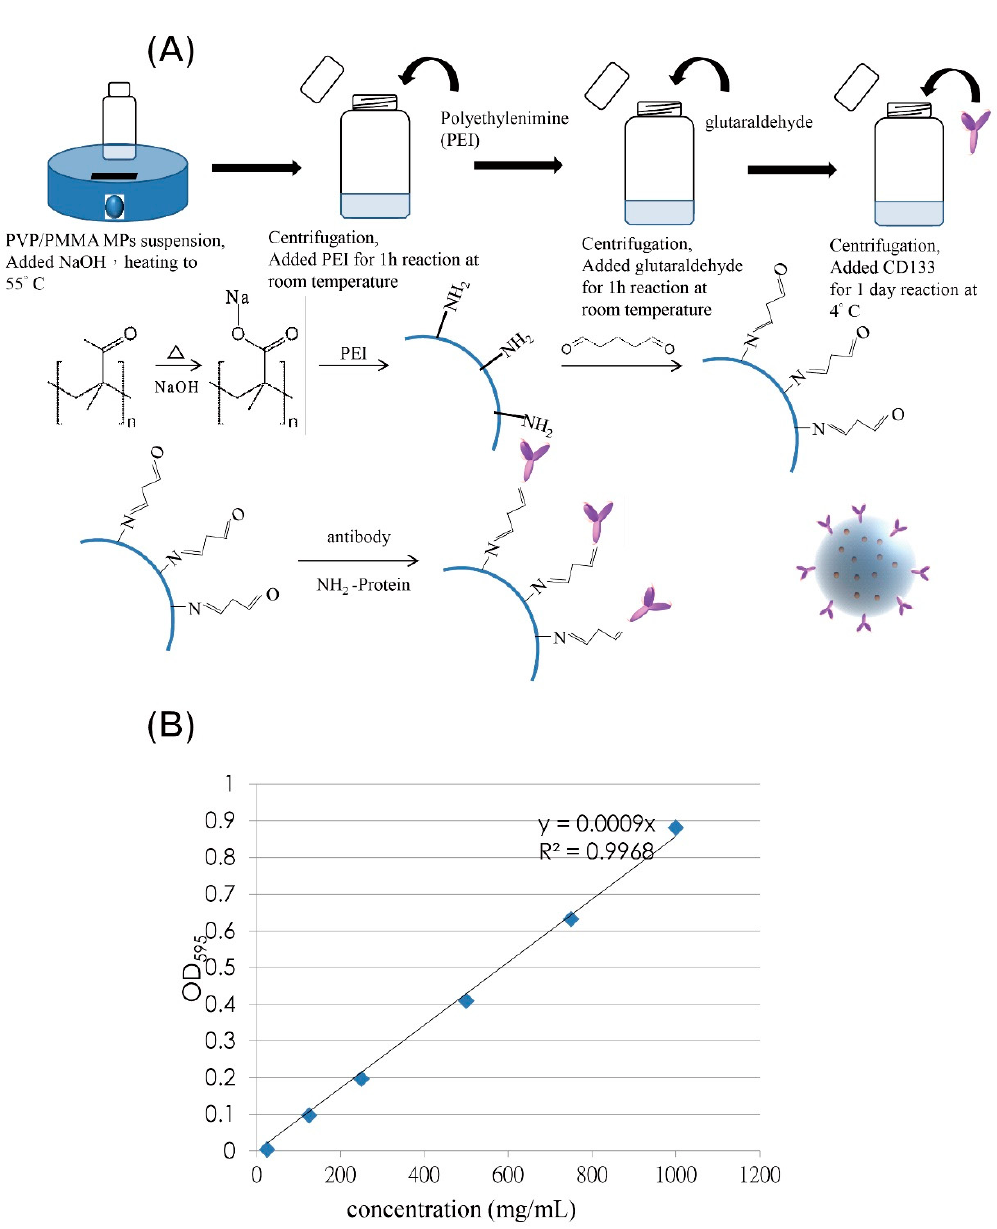
Figure 6. ( a ) Schematic illustration of facile protocol for synthesizing CD133-conjugated LEVA/PVP/PMMA microparticles. ( b ) Standard curve of Bradford assays established by using the BSA standard protein to determine the conjugation amount of antibody on the particle’s surface.